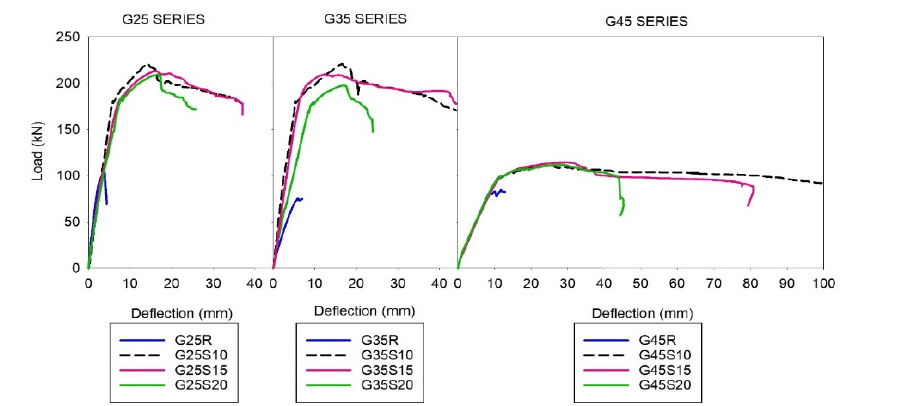
Figure 6. Load–deflection curves.